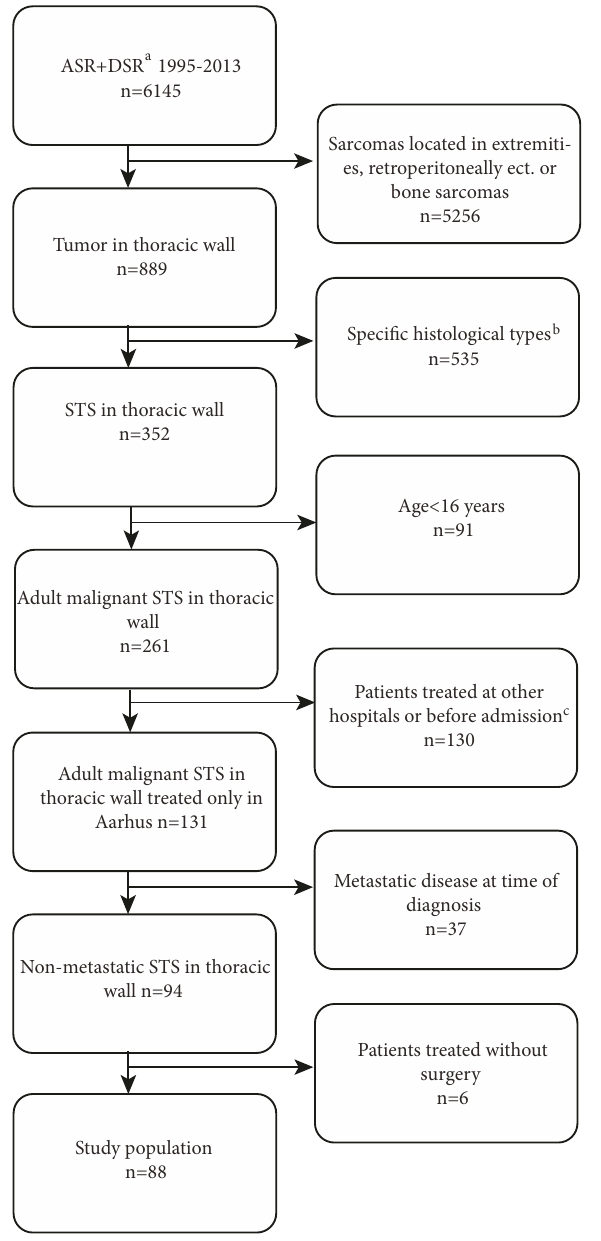
Figure 1: Flowchart of patients registered in Aarhus Sarcoma Registry (ASR) and Danish Sarcoma Registry (DSR) in the period 1995-2013. Number of patients (n), exclusion criteria, and the study population of adult patients treated surgically for a soft tissue sarcoma (STS) in the thoracic